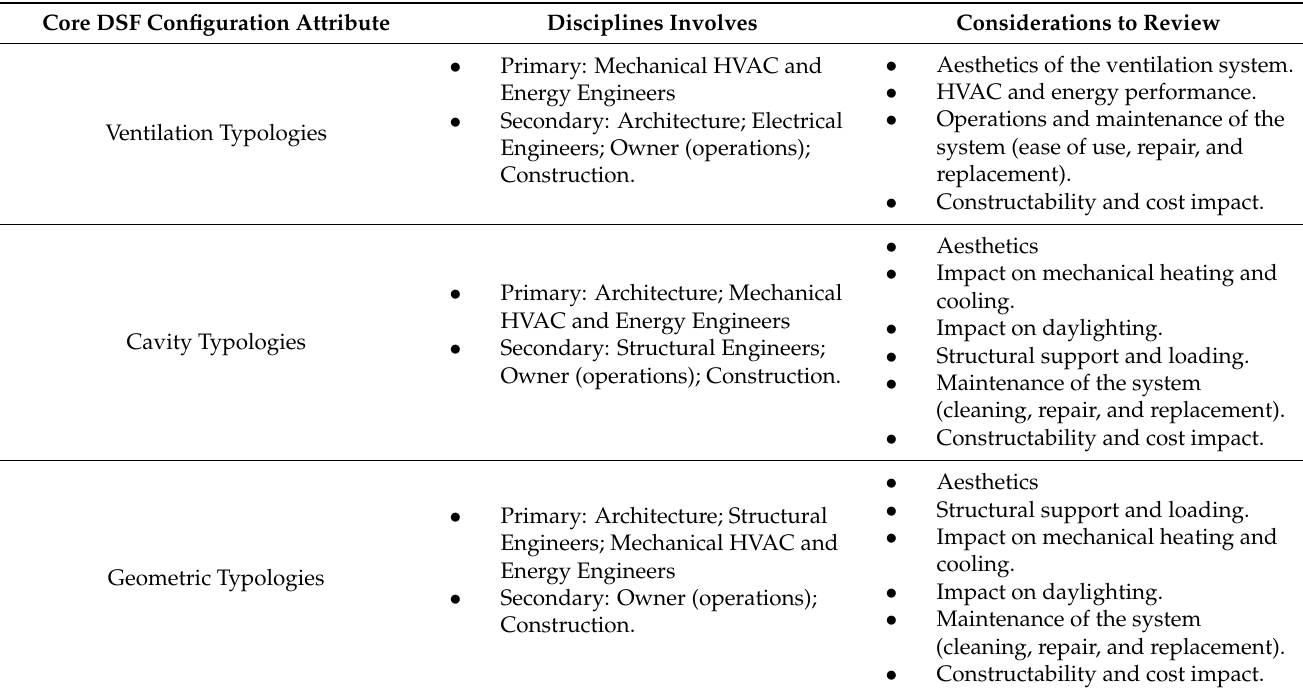
Table 5. Multi-disciplinary Consideration Takeaways of DSF